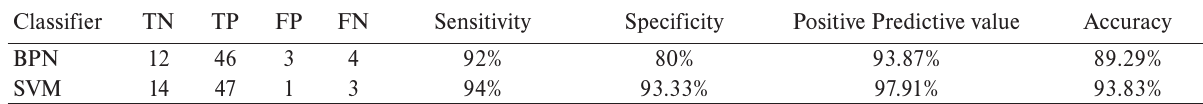
Table 4. Analysis of classification results (OCT image